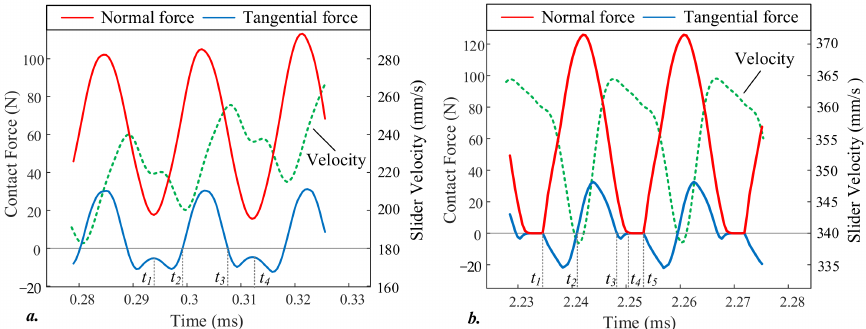
Figure 15. The time-domain response of the contact force and slider velocity: ( a ) period A in the transient state; ( b ) period B in the steady